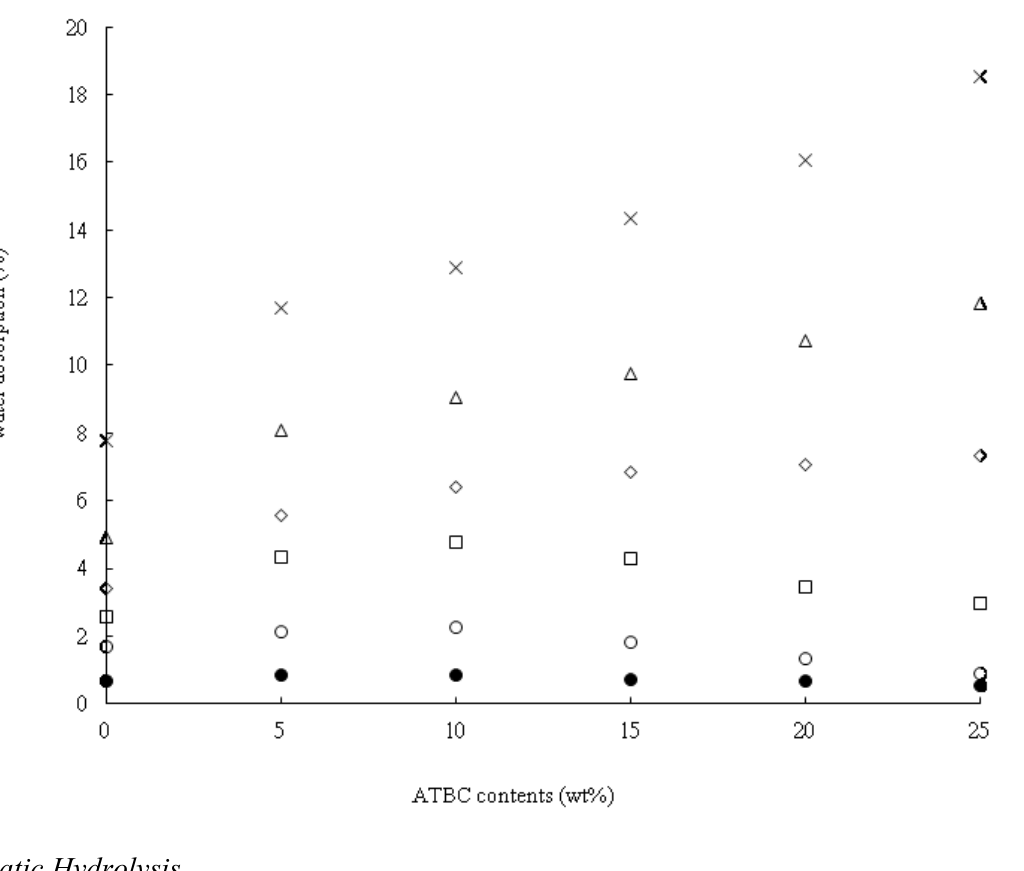
Figure 7. Water absorption vs. ATBC content for (●) PLA; (○) PLA (□) PLA (×) PLA